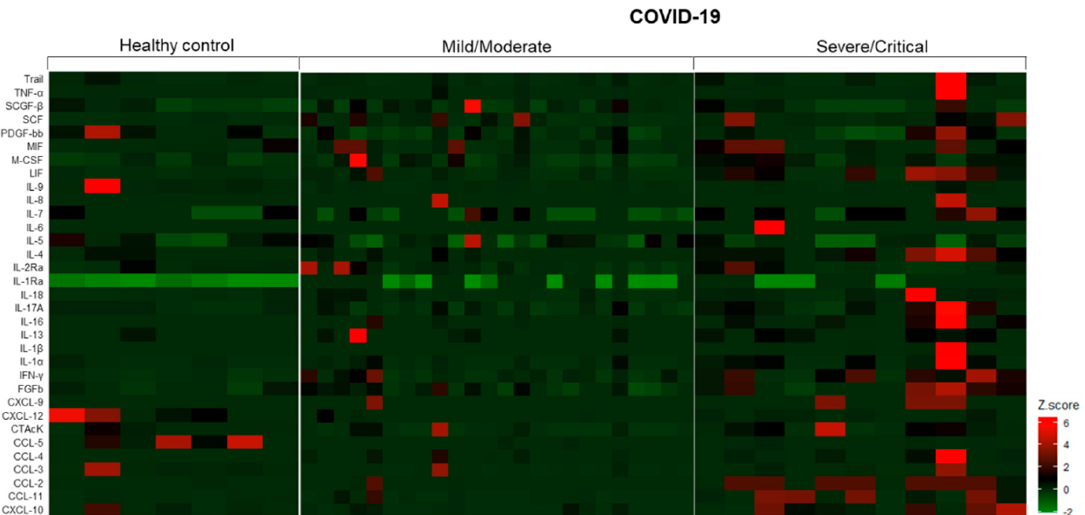
Figure 3. Landscape of urinary immune mediators in healthy controls and COVID-19 hospitalized patients. The z-score for each mediator was calculated by subtracting the observed value by the mean and dividing by the standard deviation. Table 2. Correlations between total urinary EVs and immune